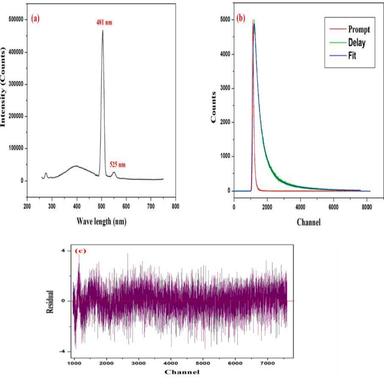
(a) Emission spectrum (b) Life time measurement (c) Residual fit of UGA.